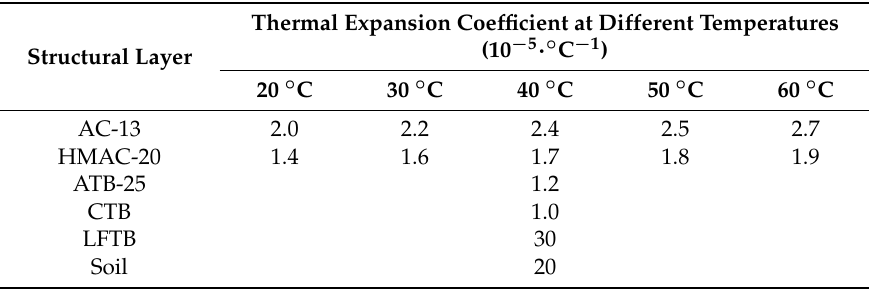
Table 9. Thermal expansion coefficients of pavement materials.